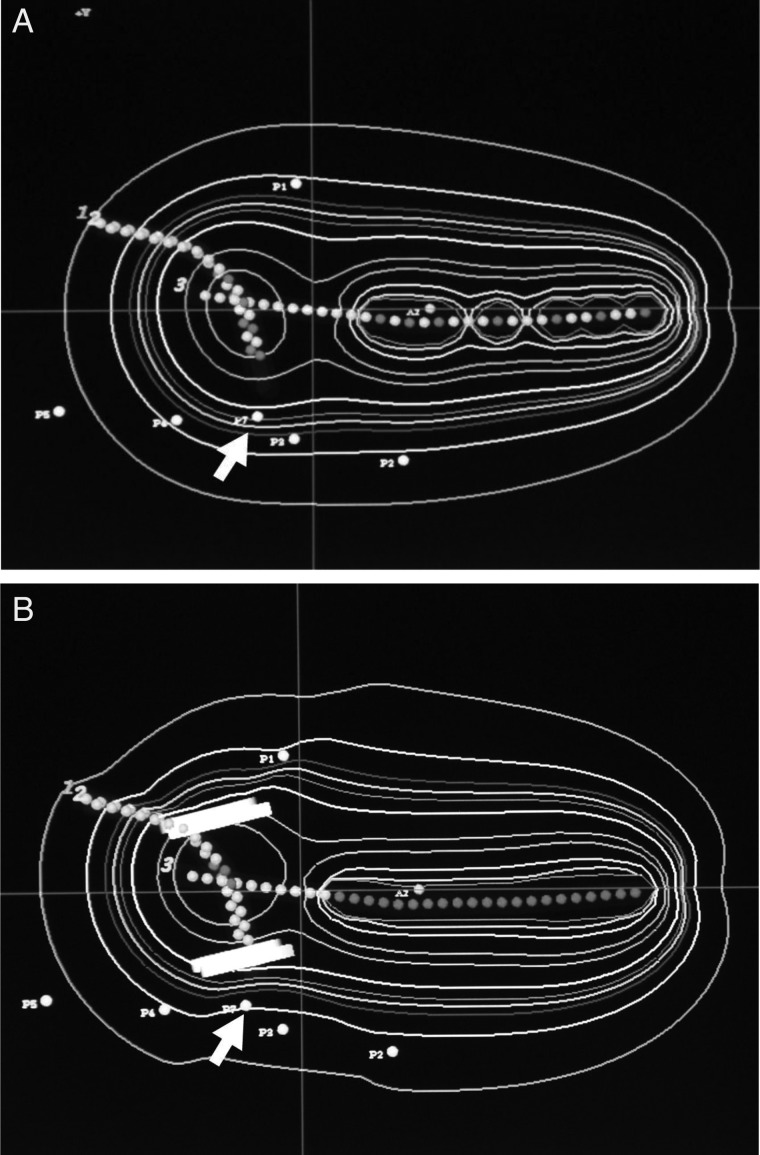
Isodose curves of Ir-RALS. The dose to the ICRU rectum point (arrow) was 138% of the Point A dose in Group A and 82% in of the Point A dose in Group B (by tungsten shielded applicator and modified source step size). From the outside, isodose curves show 50%, 80%, 100%, 110%, 120%, 140%, 200%, 150%, 400%, 600% and 800% of the Point A dose.